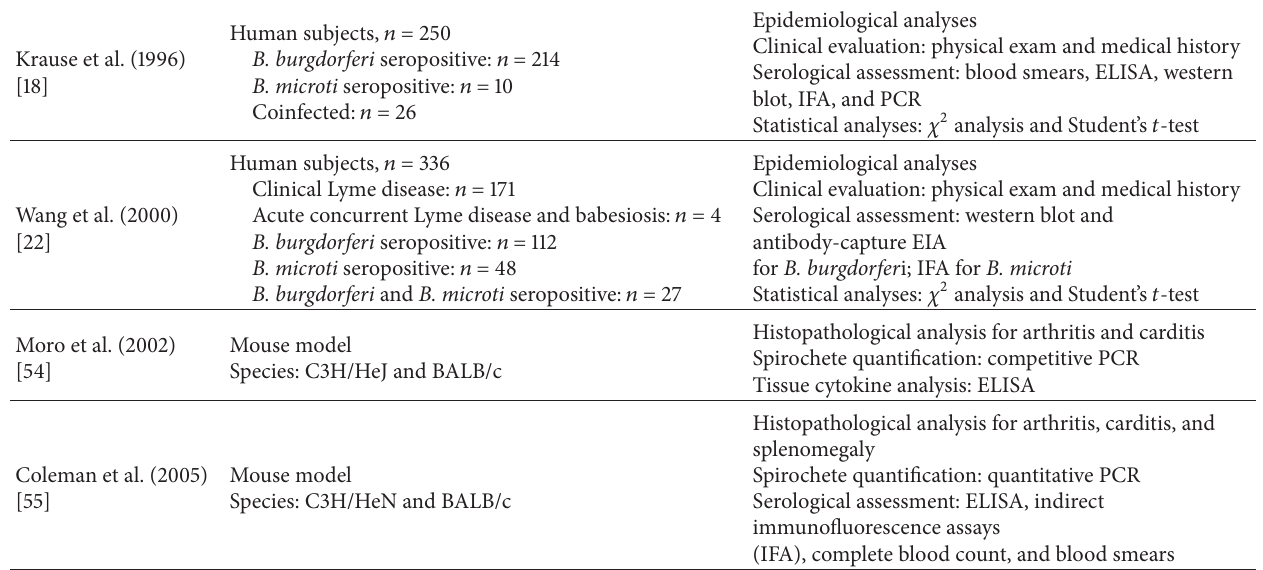
Table 3: Summary of experimental methodology from four key studies investigating the impact of B. burgdorferi and B. microti coinfection.